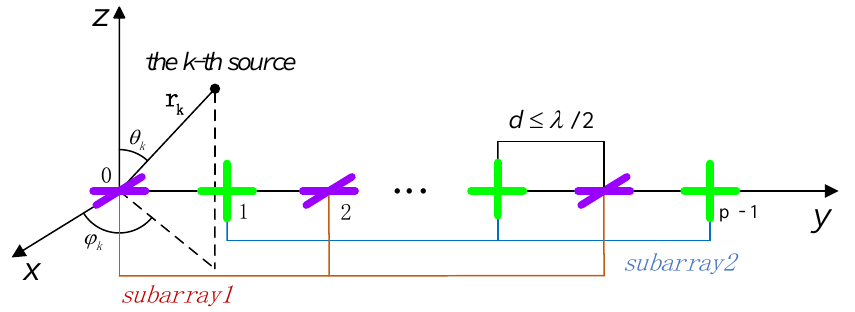
Figure 1. NF scenario in P-ULA with cross-distribution dipole pairs.